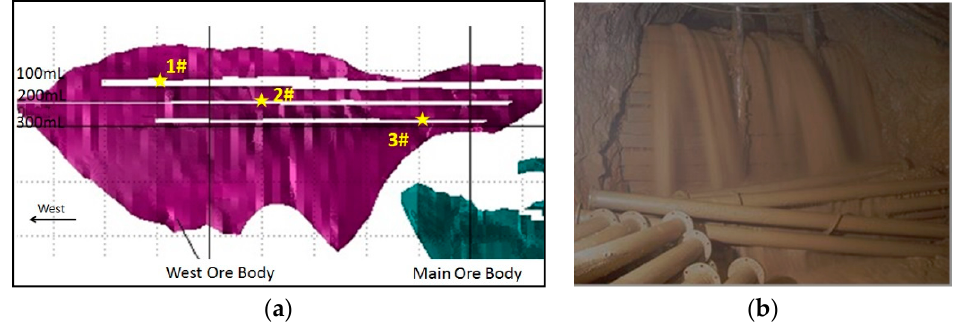
Figure 3. ( a ) Underground mine water sampling locations. ( b ) Photograph of the mine water from the roof.